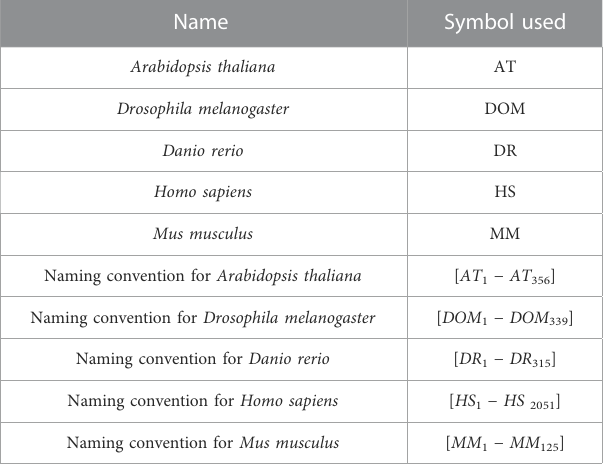
TABLE 2 Possible sets of occurrences of nucleobases A , C , T , G in a DNA sequenceoressentialgeneformed bythecombinationofvectors, where I , J , K , L , M , N , O , P are the co-occurrence matrices.